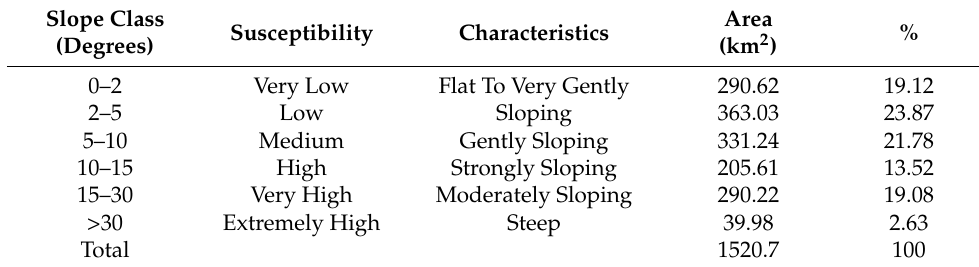
Table 2. Slope classification of the study area with related